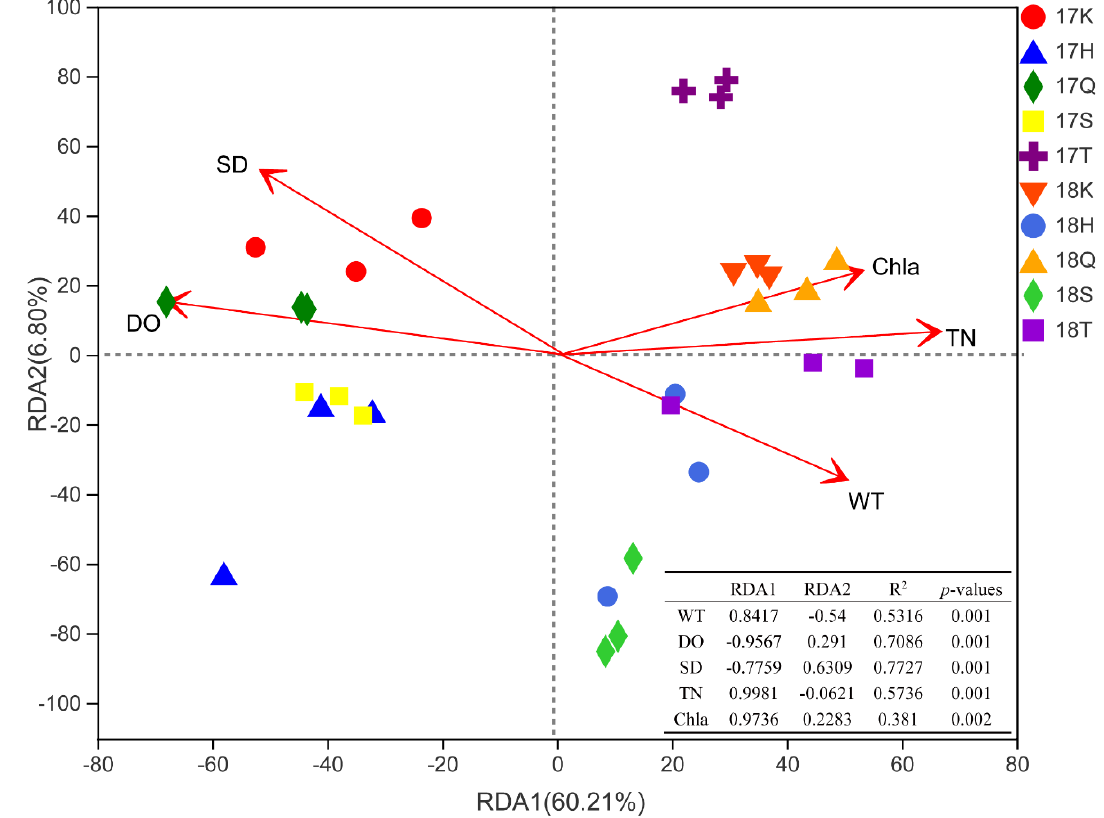
Figure 7. RDA ordination biplot of planktonic eukaryote taxa and environmental factors. The RDA table for the environmental factors is shown in the lower right of the figure.